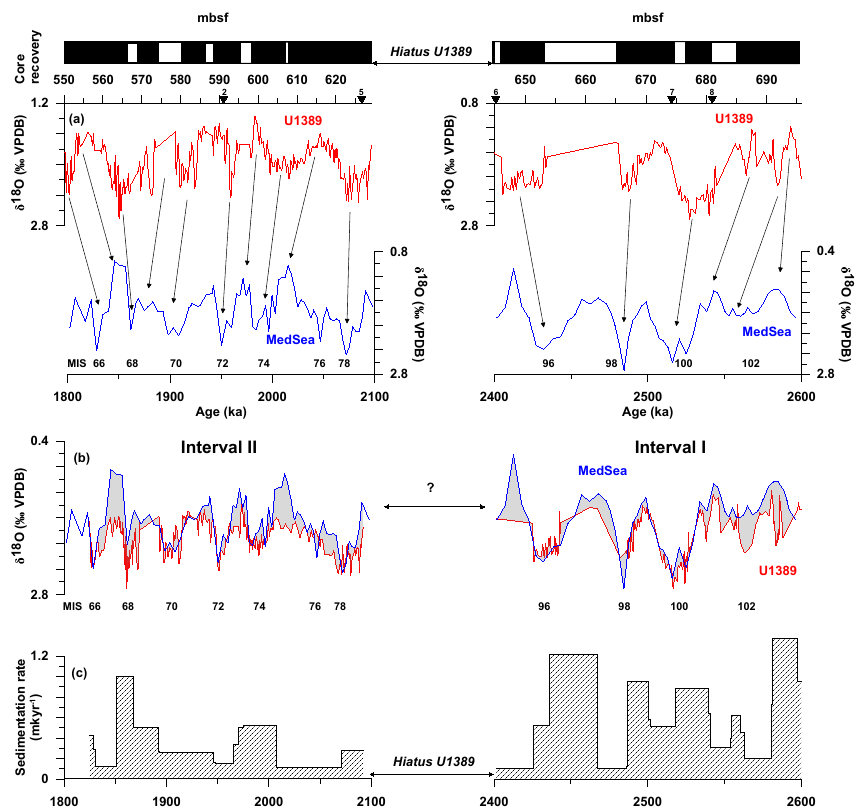
Figure 3. Chronology of Site U1389. Assigned marine isotope stages (MIS) follow Lourens et al. (1996b). (a) Both intervals of the δ 18 O record of Site U1389 on shipboard mbsf scale correlated with the benthic δ 18 O record of the Mediterranean Sea (MedSea stack) after Lourens et al. (1996a, unpublished data). Chronostratigraphy of MedSea stack is based on tuning sapropel midpoints to La2004 65 ◦ N summer insolation (Lourens, 2004). Lines with arrows indicate selected tie points used for the age model (a full list of tie points is available in Table 2). Black triangles with numbers indicate biostratigraphic and palaeomagnetic tie points used, as referenced in Table 1. Black and white bar at the top represents core recovery following Hernández-Molina et al. (2013). (b) Comparison of the benthic δ 18 O record of Site U1389 on a new timescale according to our tuning, and the benthic δ 18 O MedSea stack on its respective age model (Lourens et al., 2004). (c) Calculated sedimentation rates for Site